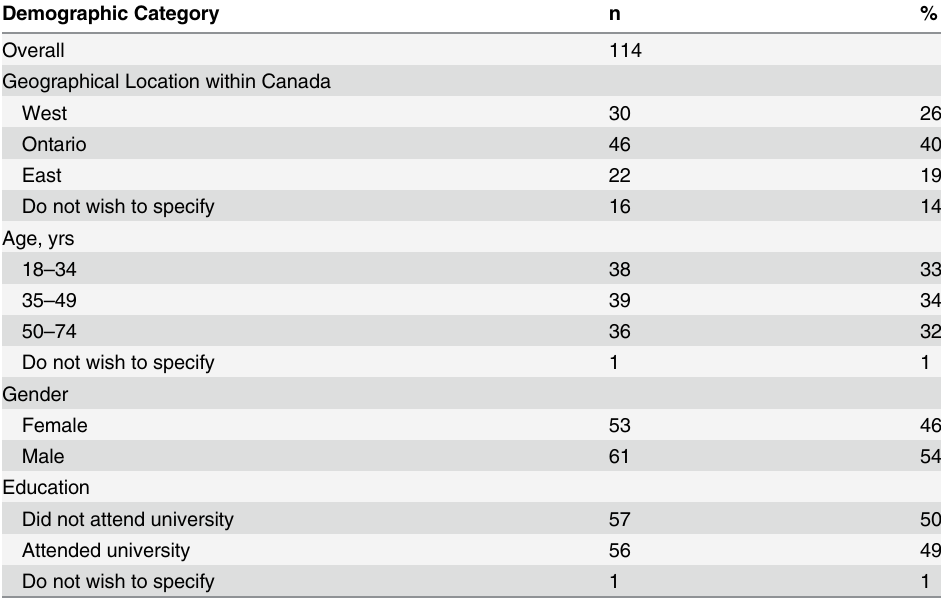
Table 1. Demographics of Survey Respondents.